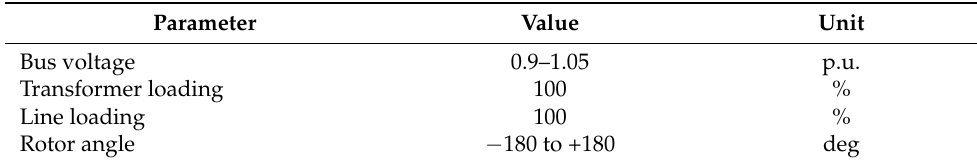
Table 2. Standard of power system operation